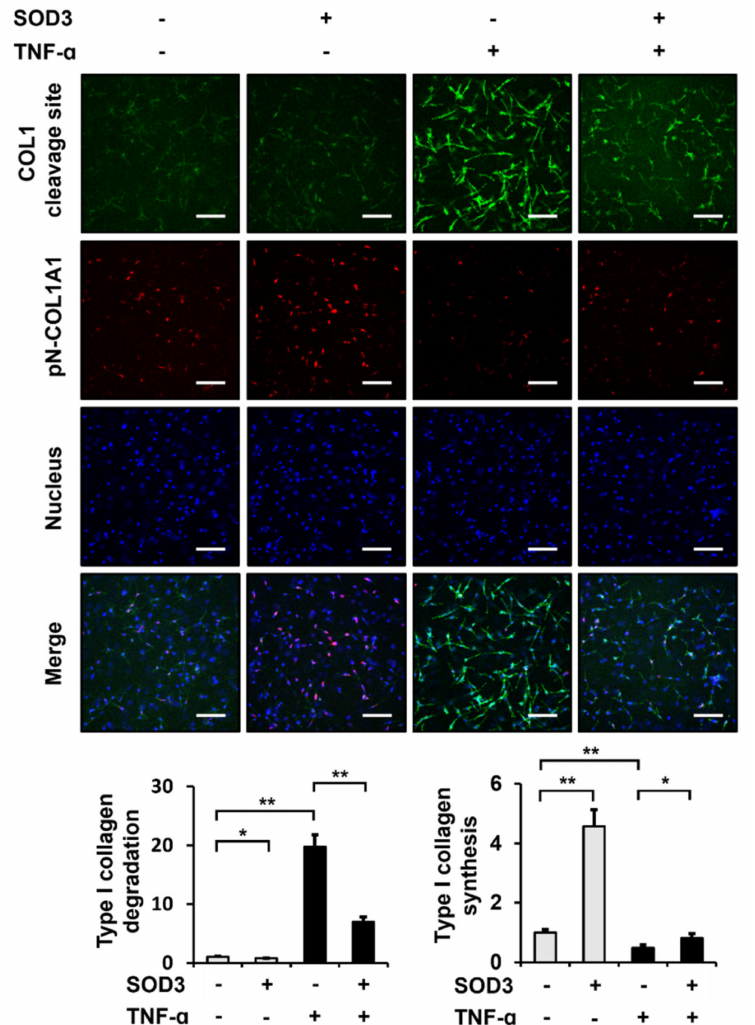
Figure 6. Effects of SOD3 on the degradation and synthesis of type I collagen in 3D cultures of fibroblasts. Foreskin fibroblasts embedded in a type I collagen matrix were incubated for 24 h with or without TNF- α (1 ng/mL) and SOD3 (3 µ g/mL). The cells in the 3D culture were analyzed via immunofluorescence staining using rabbit anti-type I collagen cleavage-site and Alexa 488-conjugated anti-rabbit IgG antibodies for type I collagen degradation, mouse anti-pN-COL1A1 and Rhodamine Red X-conjugated anti-mouse IgG antibodies for type I collagen synthesis, and Hoechst 33258 for nuclear staining. The cells were analyzed via confocal microscopy. The fluorescence intensities were assessed using the ImageJ software and normalized to nuclear staining. Graphs show the fluorescence intensities for type I collagen degradation and synthesis relative to those in untreated cells. Each value represents the mean ± standard deviation of three independent experiments. * p < 0.05 and ** p < 0.01 vs. control. Magnification, × 100. Bar = 200 µ